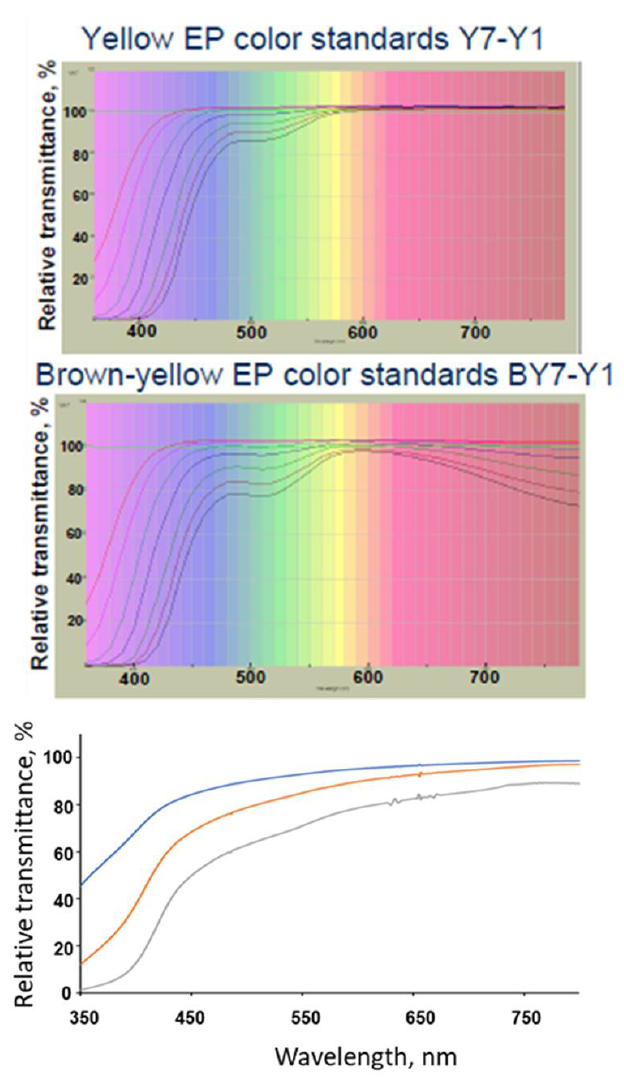
Figure 1. ( Top panels) Transmittance spectra of Yellow (Y7-Y1) and Brown-Yellow (BY7-BY1) EP standards. ( Bottom panel) transmittance of non-stressed colorless mAb solutions at 13.5 mg/mL (blue trace), 50 mg/mL (red trace), and 135 mg/mL (gray trace). Adapted from reference [4], top panels reproduced with permission from HunterLab.